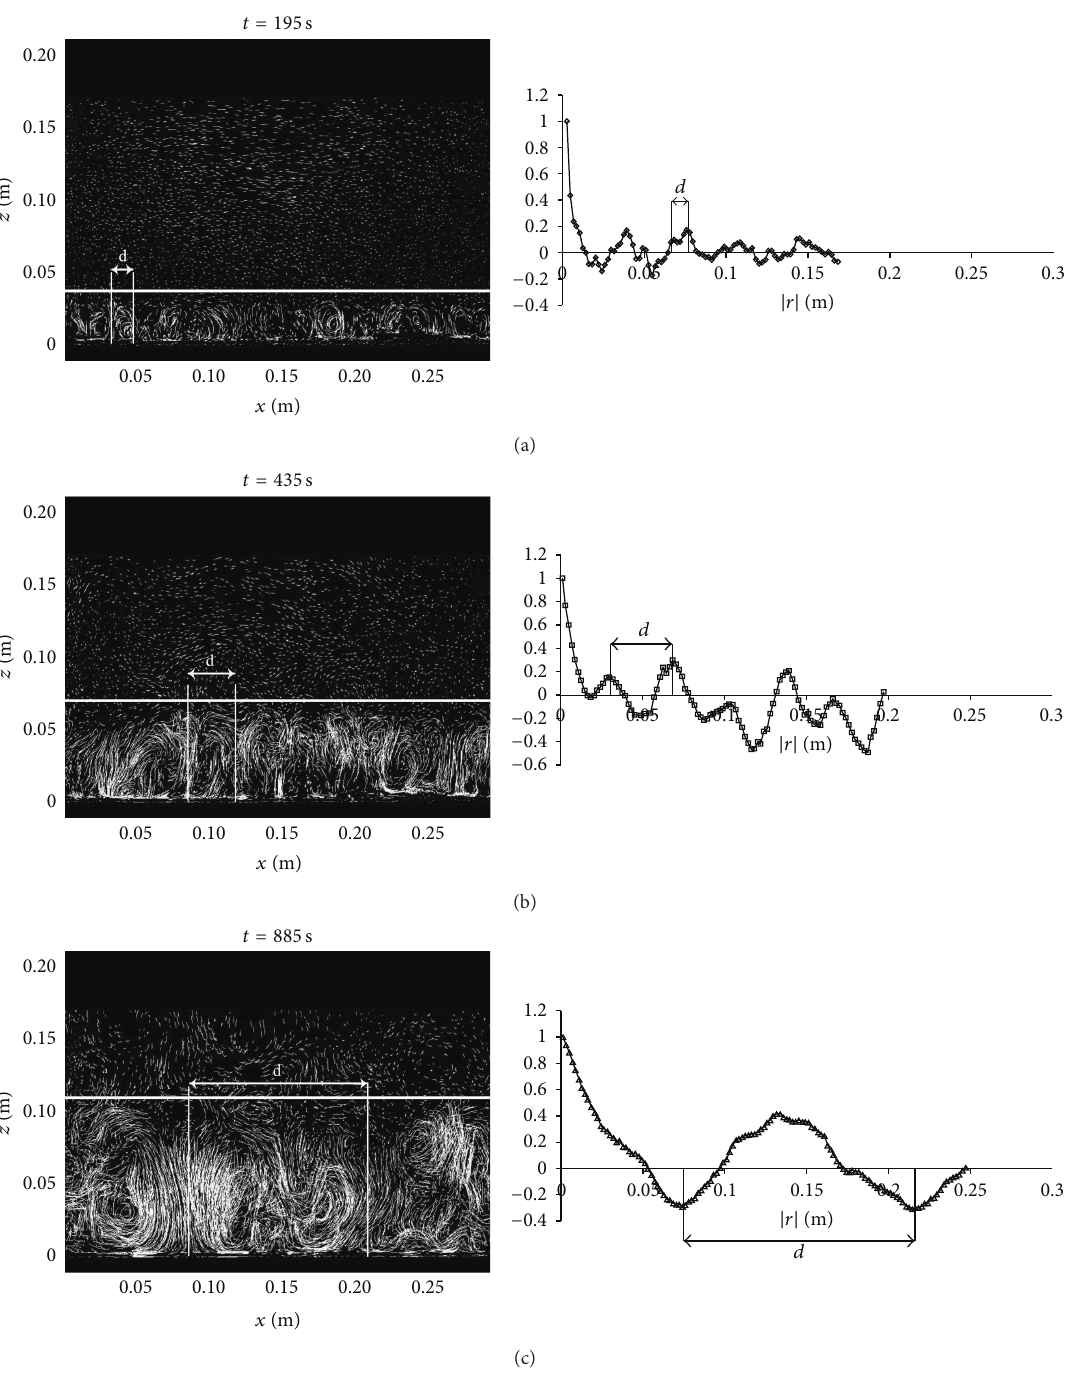
mixing phenomena and pollutants are confined into the convective